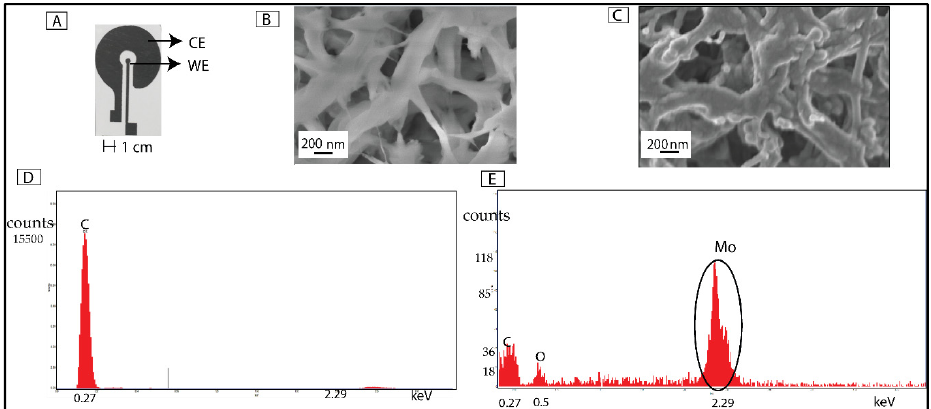
Figure 1. Material characterization of molybdenum (Mo) biosensor. ( A ) Representation of Mo sensor on polyamide substrate. CE represents the counter electrode and WE represents working electrode; ( B ) Representation of scanning electron microscope (SEM) image of Mo sensor on the porous polyamide substrate before Mo deposition; ( C ) Representation of SEM image of Mo sensor on the porous polyamide substrate before Mo deposition; ( D ) Representation of energy dispersive X-ray spectroscopy (EDAX) spectrum analysis on polyamide (PA) membrane before Mo deposition; ( E ) Representation of EDAX spectrum analysis on the Mo sensor. The encircled region on the EDAX spectrum indicates the peak corresponding to the L-shell energy peak of the Mo.